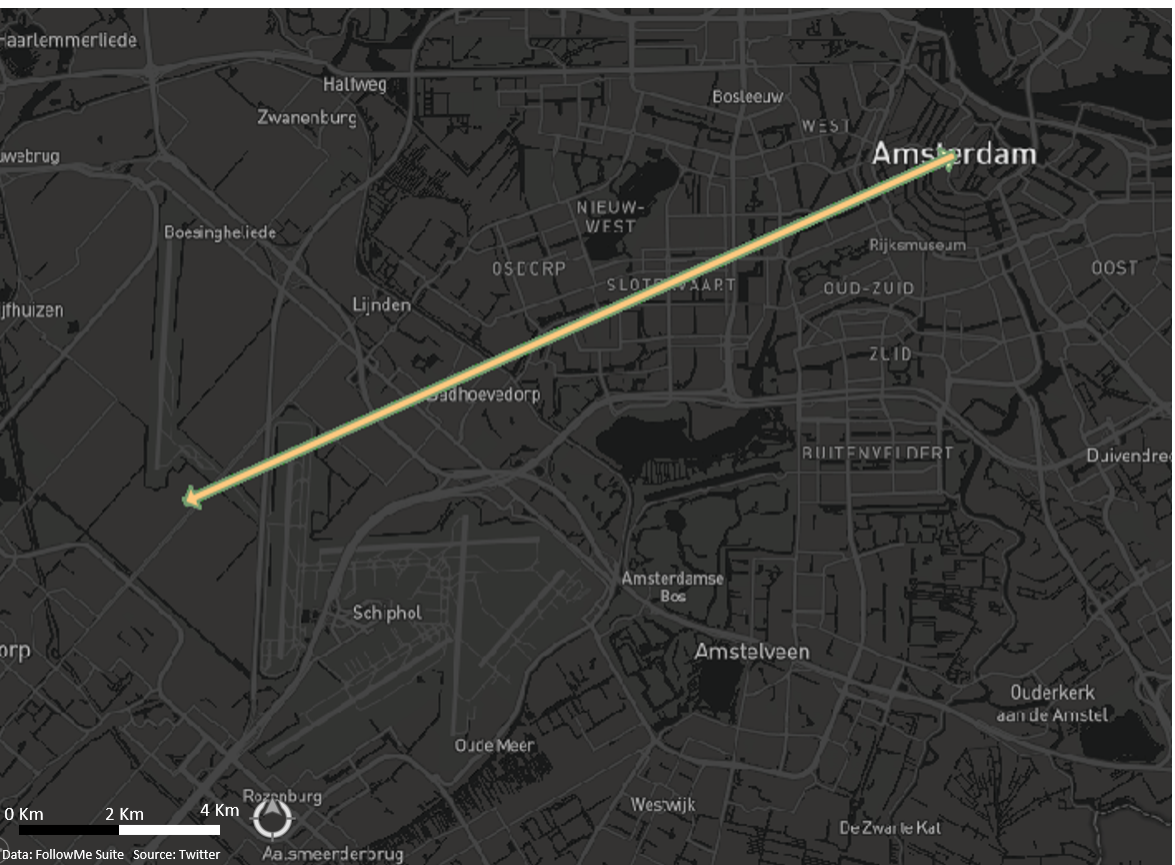
Figure 13. Topographic representation for discovered itemsets from the large data set by applying Interpretation 2, focused on Amsterdam